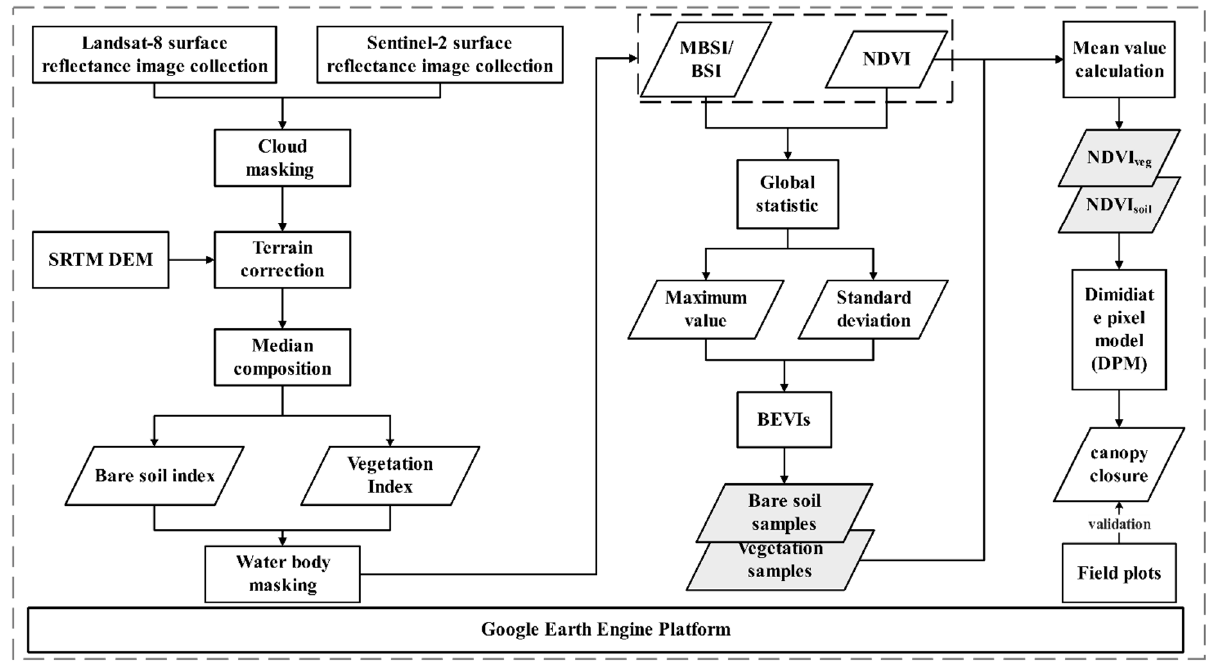
Figure 3. Workflow of forest canopy closure estimation (NDVI refers to normalized difference vegetation index, MBSI refers to modified bare soil index, BSI refers to bar soil index, and BEVIs refers to bounding envelope method based on vegetation indices).